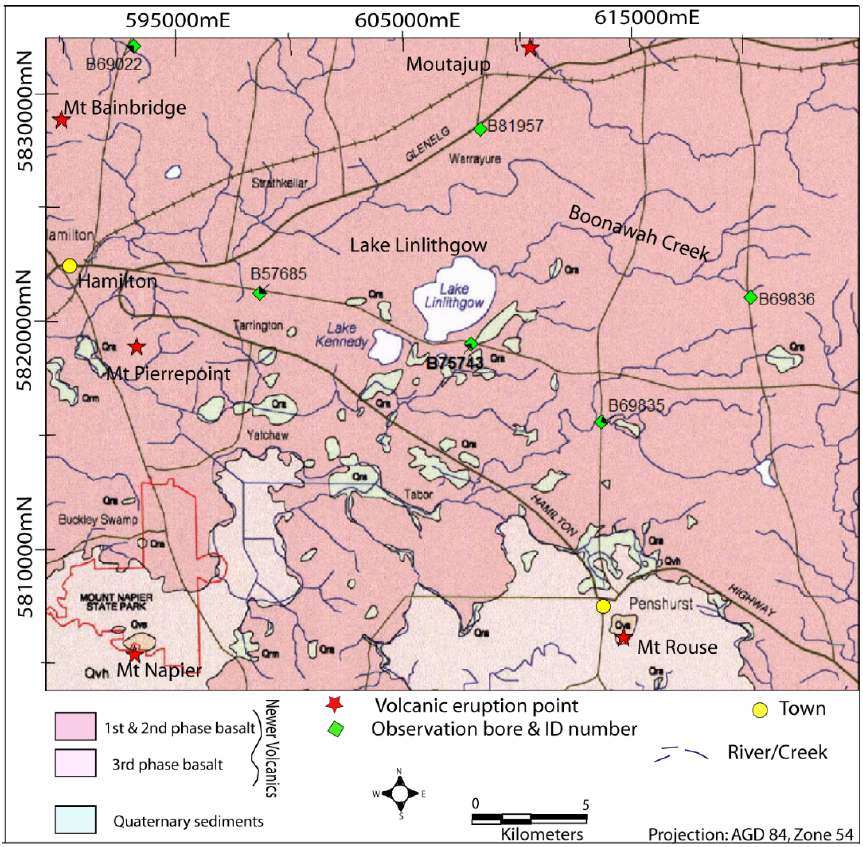
Figure 3. Geological map of the area surrounding Lake Linlithgow.